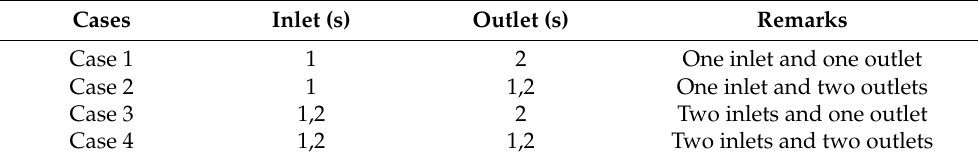
Table 4. Simulated cases.